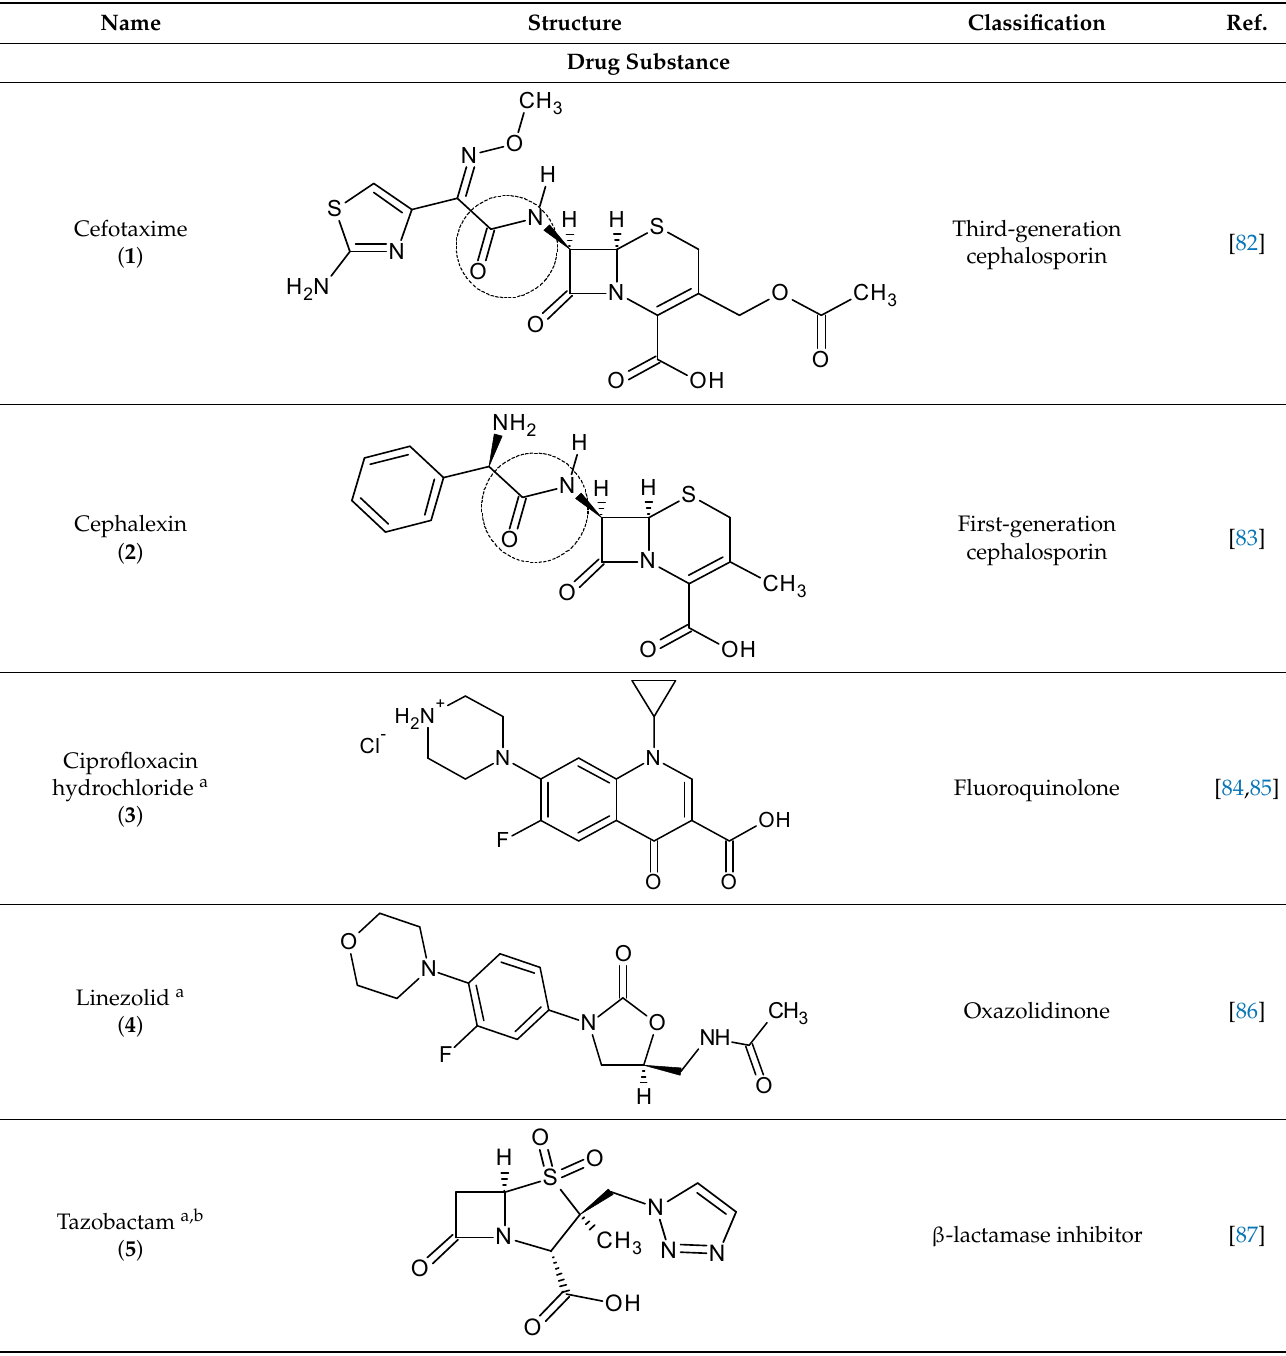
Figure 2. The advantages of flow chemistry for the pharmaceutical industry. Table 1 lists all of the antibiotics for whose synthesis flow chemistry has been applied. They will be discussed in the subsequent sections. Table 1. Overview of antibiotic drugs studied under flow chemistry.